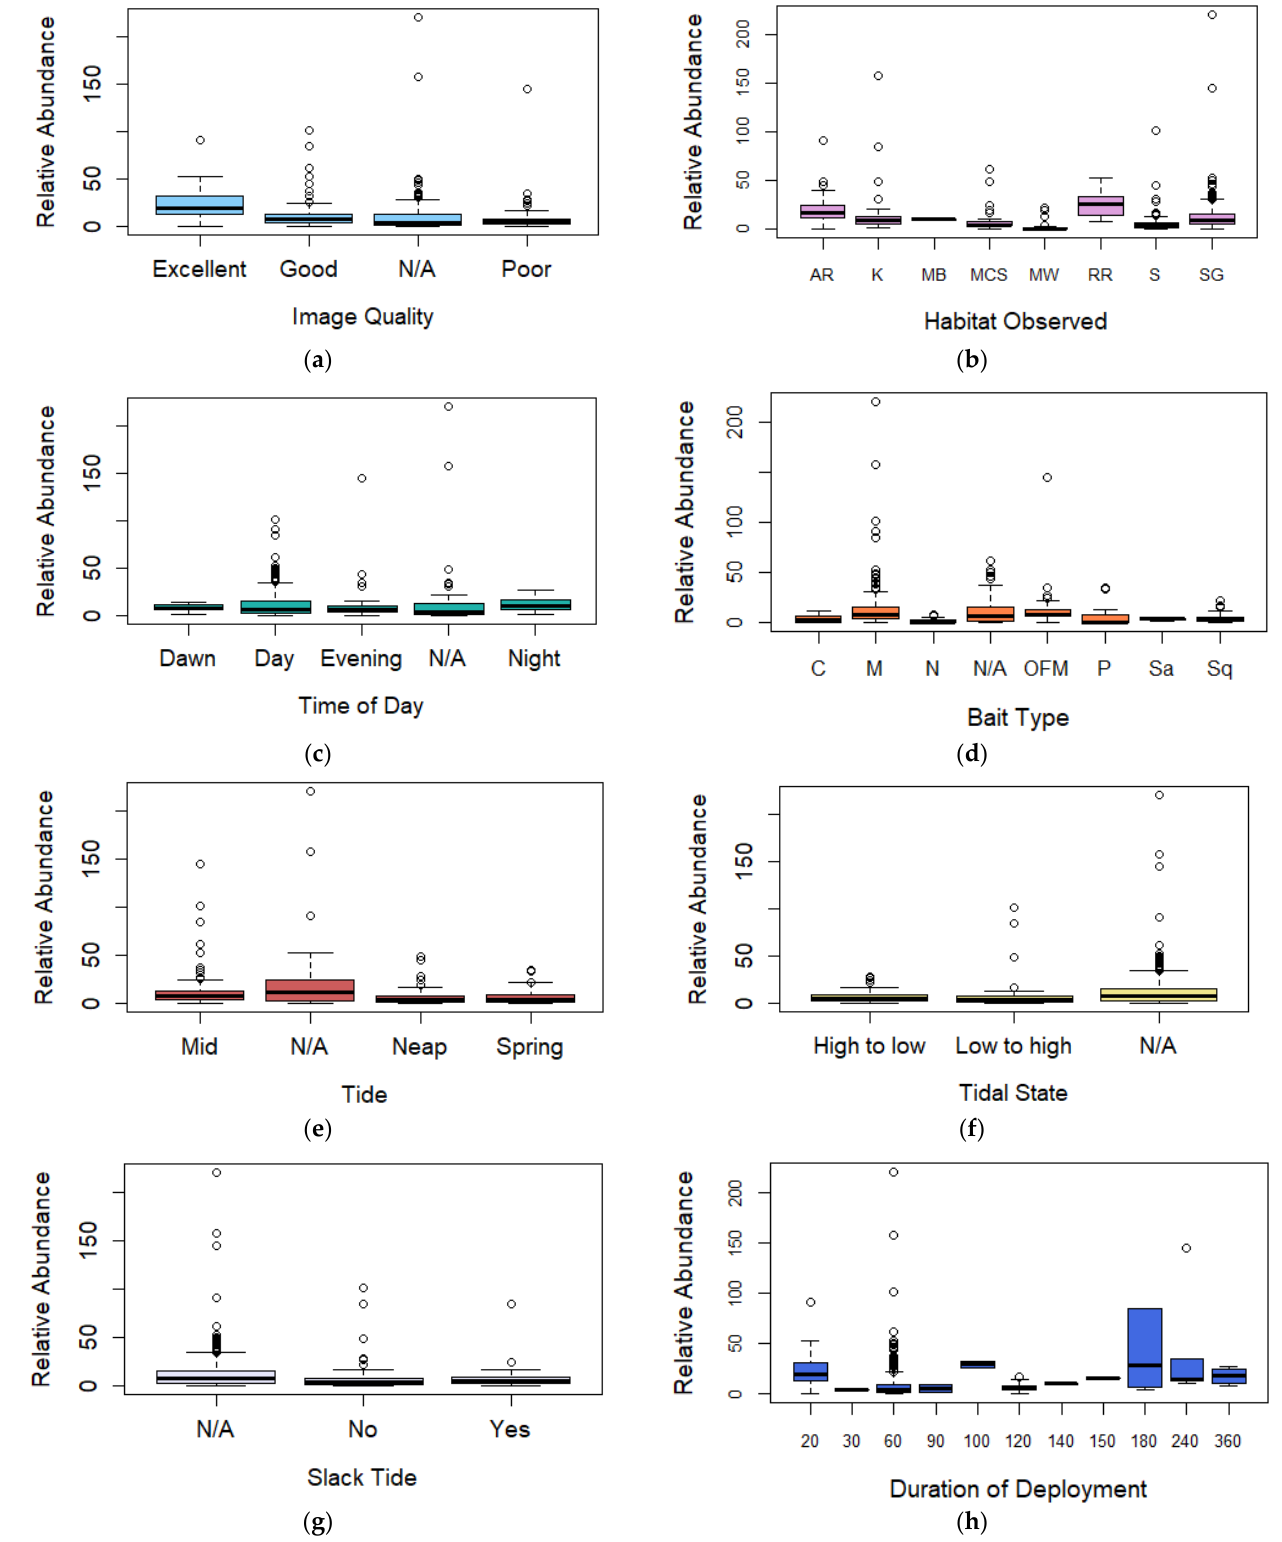
Figure 4. Boxplot (box ranging from first to third quartile and highlighting median value, whiskers extending to 1.5 the interquartile distance with circles indicating outliers) comparing relative abundance for ( a ) image quality, ( b ) broad hab- itat observed, ( c ) time of day, ( d ) bait type, ( e ) spring/neap tides, ( f ) tidal state, ( g ) slack tide, and ( h ) duration of deploy- ment. AR = Artificial Reef, K = Kelp, MB = Mussel Beds, MCS = Mixed Coarse Sediment, MW = Midwater, RR = Rocky Reef, S = Sand, SG = Seagrass, C = Crab, M = Mackerel, OFM = Oily fish meal and fish oils, N = No bait, P = Prawn, Sa = Sardines, and Sq =